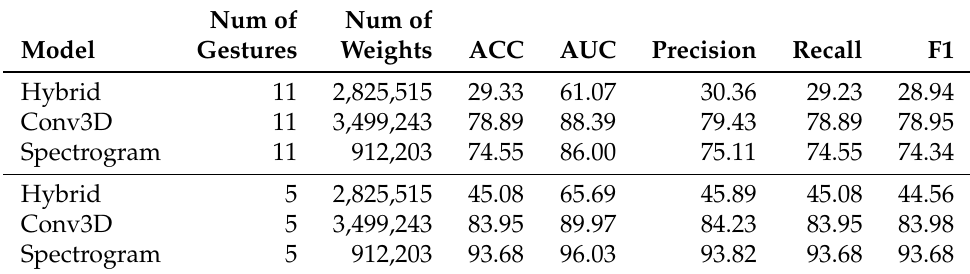
Figure 9. Per user evaluation of model architectures at varying dB range settings. The graphs show a similar trend across all users (e.g., drastic improvements stop at dB range [ − 8,0]). Table 3. Evaluating model architectures at optimal dB range [ −